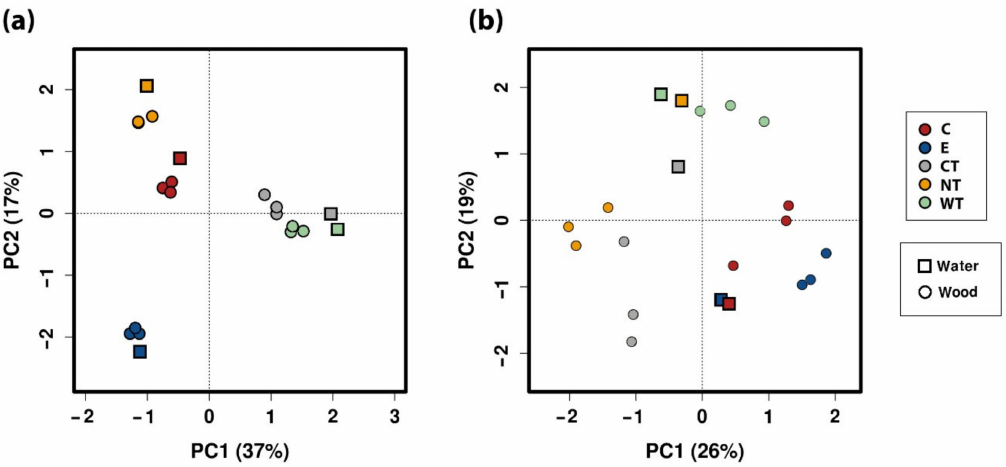
Figure 8. Principal component analysis calculated on the 16S ( a ) and ITS ( b ) ecological matrices at the level of OTU. (C: cinnamon; E: ethanol; CT: common thyme; NT: not-treated control; WT: wild thyme).